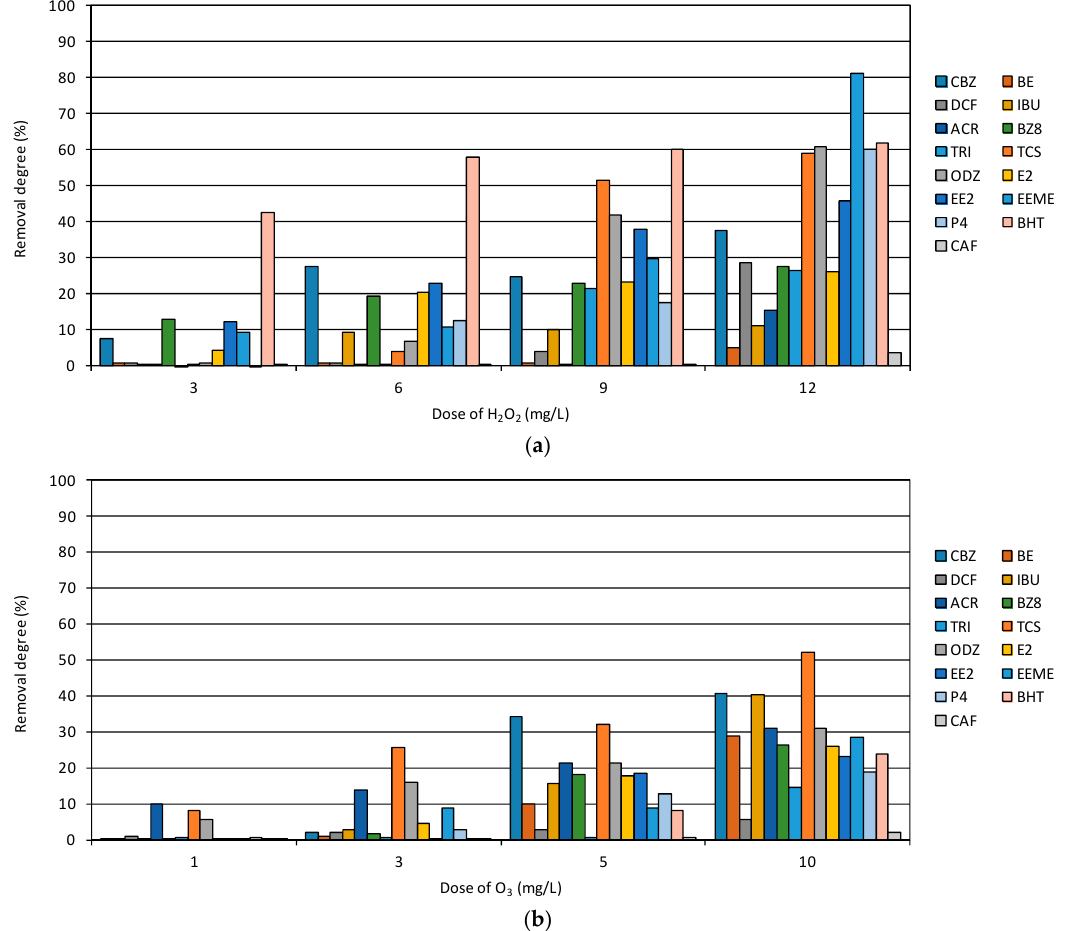
Figure 2. Degradation of micropollutants in the ( a ) H 2 O 2 and ( b ) O 3